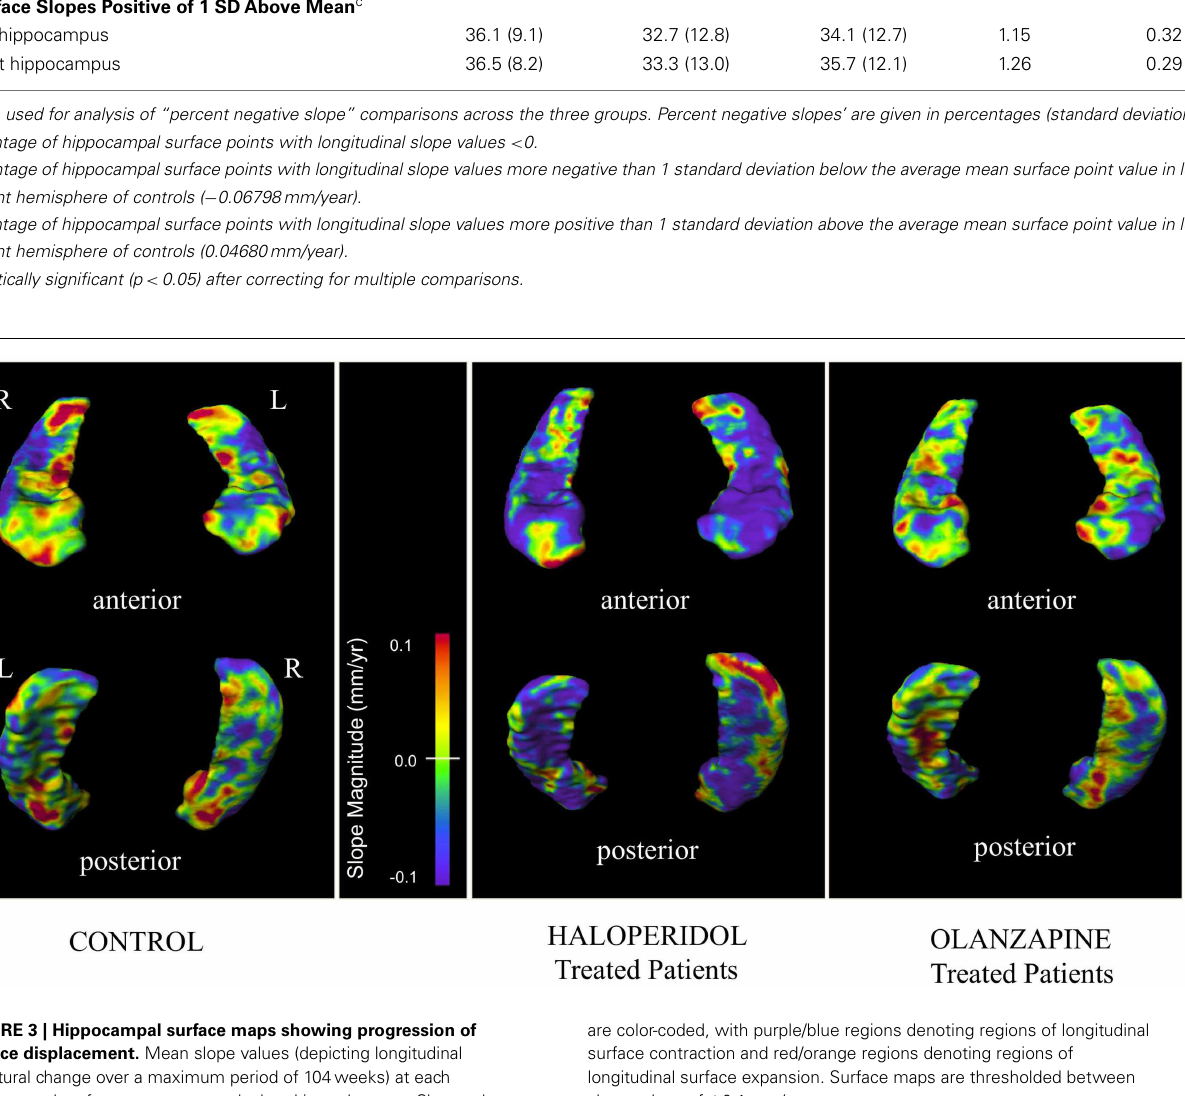
FIGURE 3 | Hippocampal surface maps showing progression of surface displacement. Mean slope values (depicting longitudinal structural change over a maximum period of 104weeks) at each hippocampal surface vertex were calculated in each group. Slope values